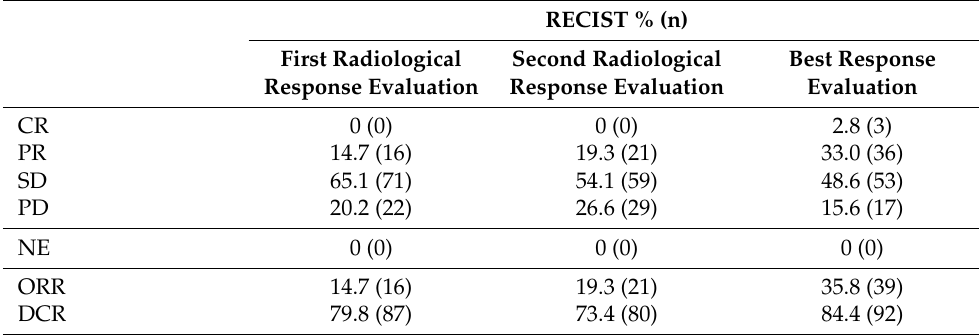
Table 2. Radiological responses to atezolizumab plus bevacizumab by Response Evaluation Criteria in Solid